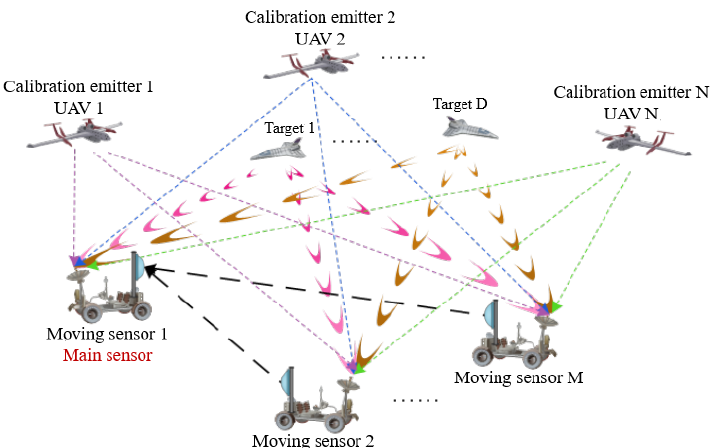
Figure 16. Multi-sensors, multi-emitter calibration, and multi-agent geometry